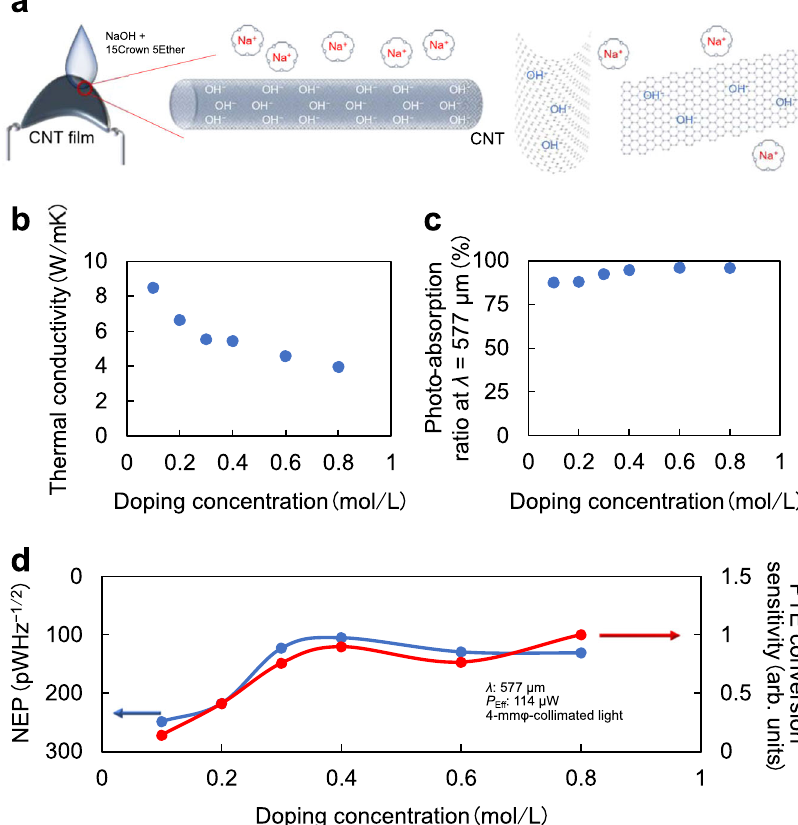
Fig. 1 Photo-thermoelectric (PTE) conversion tuning in response to concentration of N-type chemical-carrier dopant. a Schematic of N-type doping on P-type carbon nanotube (CNT) fi lms. The change in dopant concentration resulted in the tuning of each PTE parameter including b thermal conductivity, c photo-absorption ratio ( λ = 577 µ m), Seebeck coef fi cient (Supplementary Fig. 4a), and electrical resistance (Supplementary Fig. 4b). d Change in the noise equivalent power (NEP) value and the PTE conversion sensitivity vs. the N-type doping concentration. The experimentally obtained minimum NEP values of the proposed CNT- fi lm photo-imager at broad wavelength bands (millimetre-wave (MMW) — near-infrared (NIR)) are as follows: 236 pWHz − 1/2 ( λ = 1.15 mm, V = 3.26 mV, P Eff = 256 µ W, Beam spot: 10-mm φ -collimated), 105 pWHz − 1/2 ( λ = 577 µ m, V = 328 µ V, P Eff = 114 µ W, Beam spot: 4-mm φ - collimated), 30 pWHz − 1/2 ( λ = 300 µ m, V = 598 µ V, P Eff = 5.97 µ W, Beam spot: 4-mm φ -collimated), 8.57 pWHz − 1/2 ( λ = 10.3 µ m, V = 13.8 mV, P = 39.3 µ W, Beam spot: 1 mm φ ), and 11.1 pWHz − 1/2 ( λ = 870 nm, V = 421 µ V, P = 1.55 µ W, Beam spot: 5-mm φ -collimated), for the device with an Eff Eff electrical resistance of 555 Ω